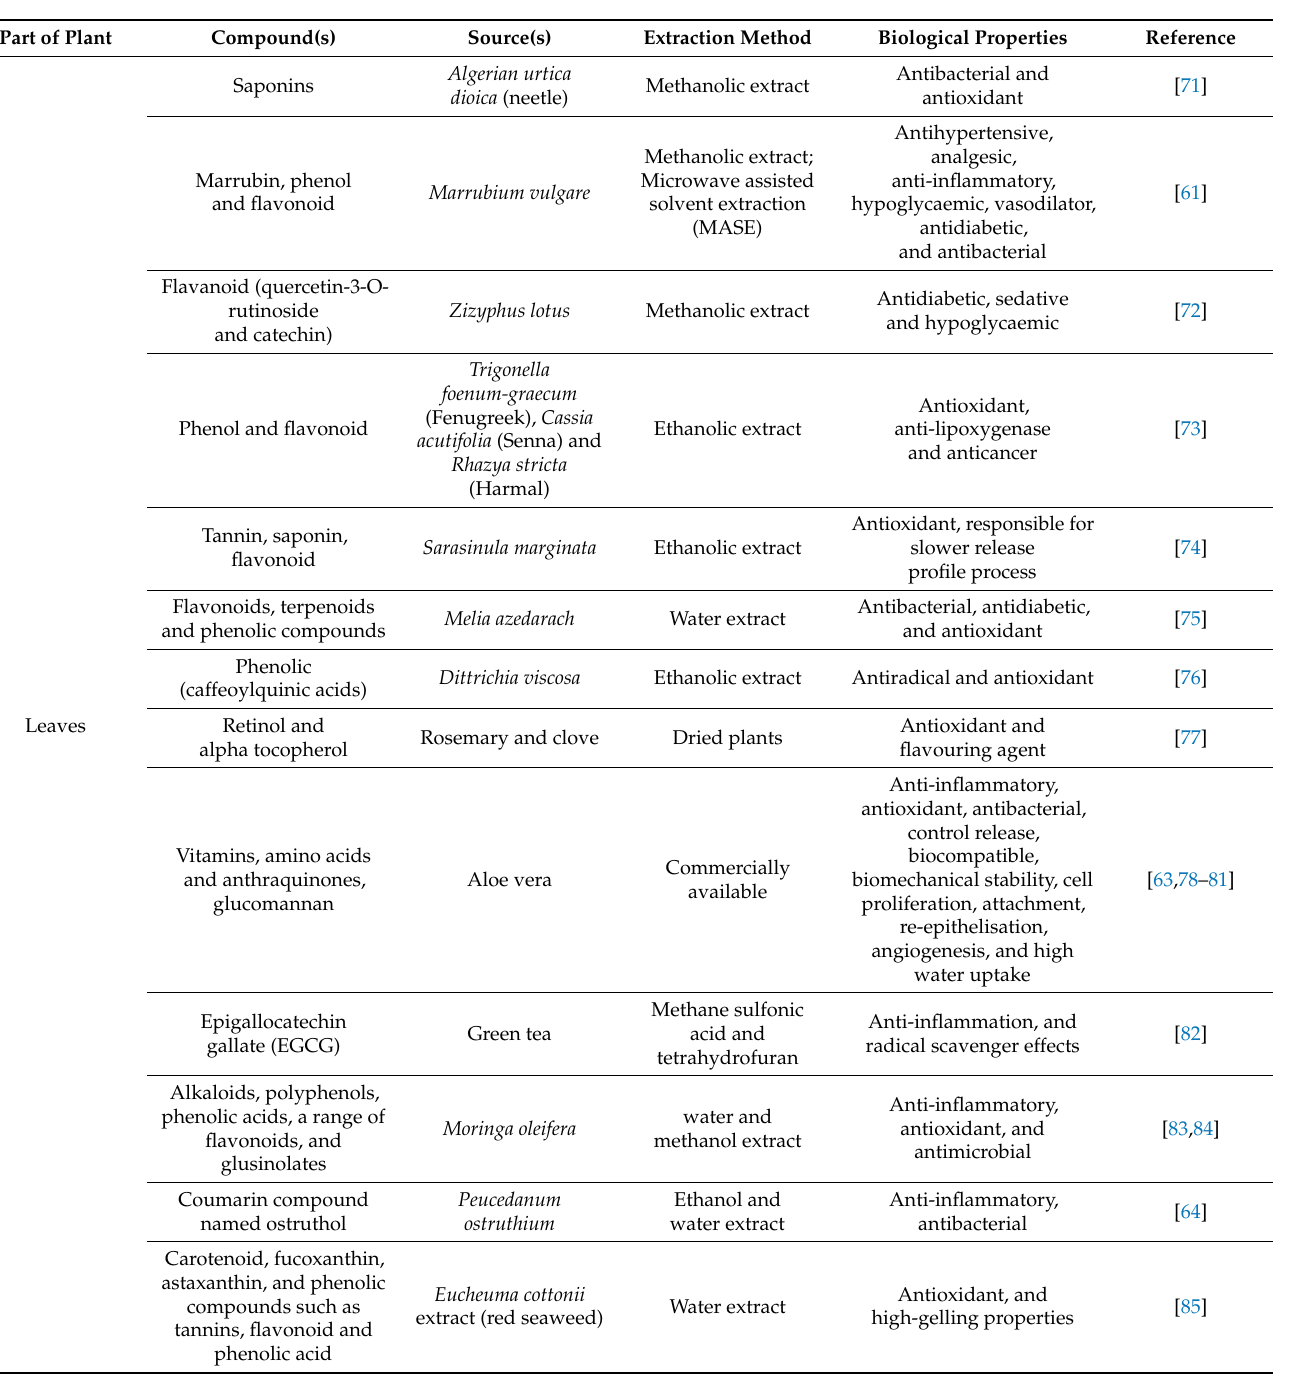
Table 1. Different sources of natural antioxidants from different parts of